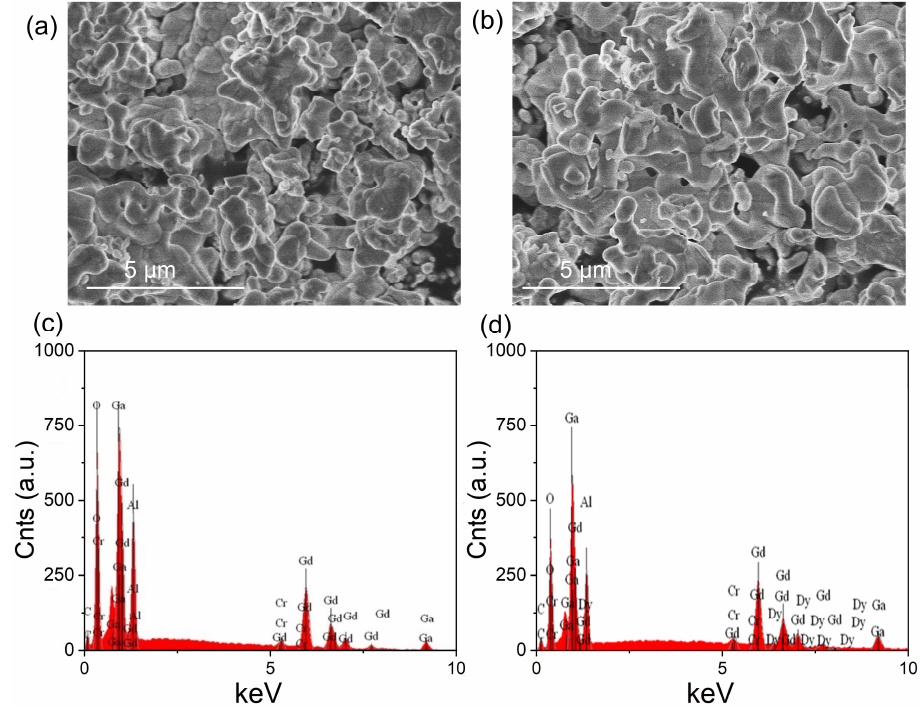
Figure 2. SEM photographs of GAGG:Cr 3+ ( a ) and GAGG:0.1Cr 3+ , 0.01Dy 3+ ( b ). EDS of GAGG:0.1Cr 3+ ( c ) and GAGG:0.1Cr 3+ , 0.01Dy 3+ ( d